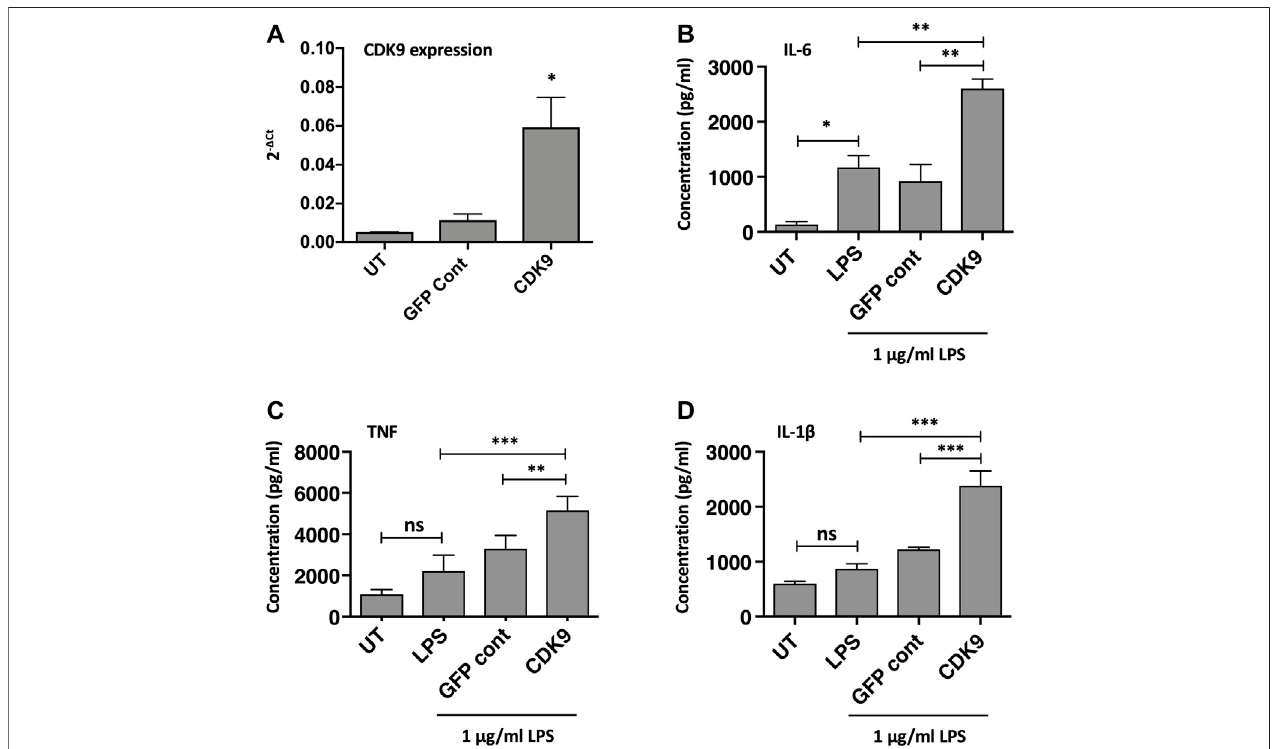
FIGURE6 | Genetic over-expression ofCDK9 augmentsLPS-inducedpro-in fl ammatory cytokine release from THP-1 cells. (A) CDK9 mRNA expression in THP-1 cells in either untreated (UT), GFP control and CDK9 plasmid transfected THP-1 cells, assayed by Real Time PCR. (B – D) Cytokine release determined by ELISA, comparingreleaseofIL-6 (B) ,TNF (C) andIL-1 β (D) cytokinesbyuntransfected(UT),GFPcontrolandCDK9plasmidtransfectedcellsinresponseto6 hstimulationwith 1 μ g/ml LPS. Data represent means ± SEM from n = 3 experiments, * p < 0.05 ** p < 0.01 *** p <